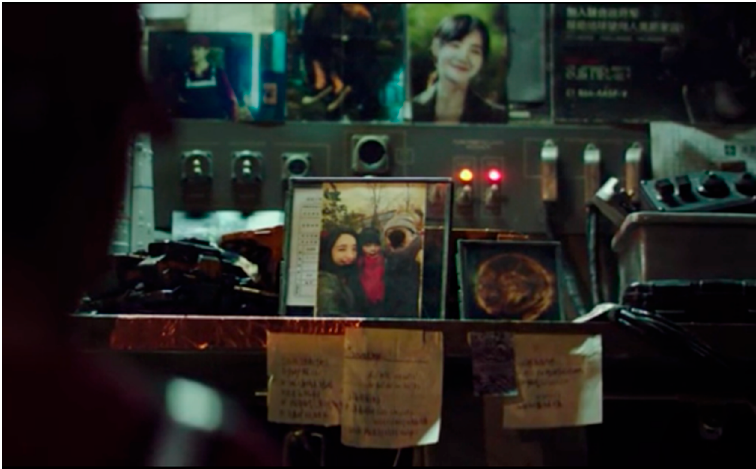
Figure 1. Liu Qi has scooped out Liu Peiqiang’s face from the family photo.